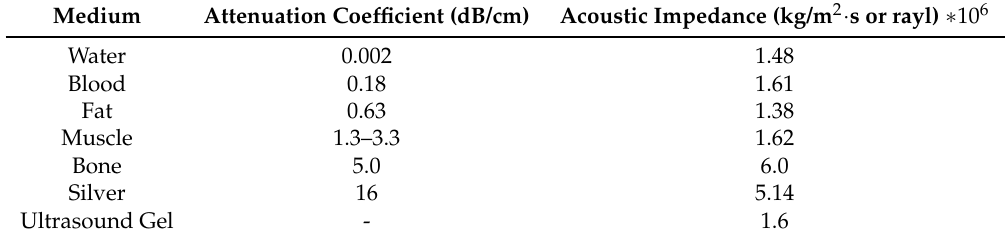
Table 1. Acoustic properties of biological